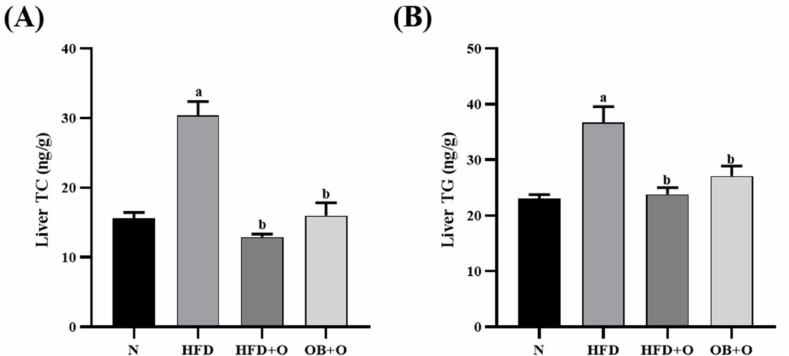
Figure 3. Liver lipid content in HFD-induced MAFLD rats. N, normal control; HFD, high-fat